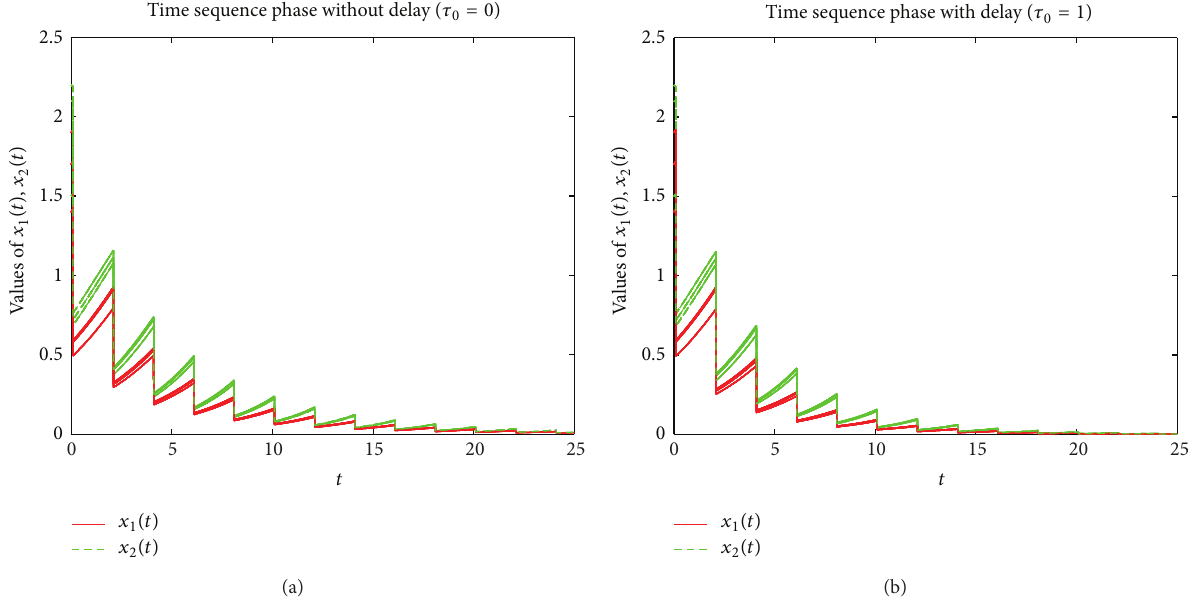
Figure 2: (a) and (b) Dynamical behavior of system (4). Here, we take three sets of initial values (1.7, 2.1), (1.9, 1.5), and (1.4, 2.2).